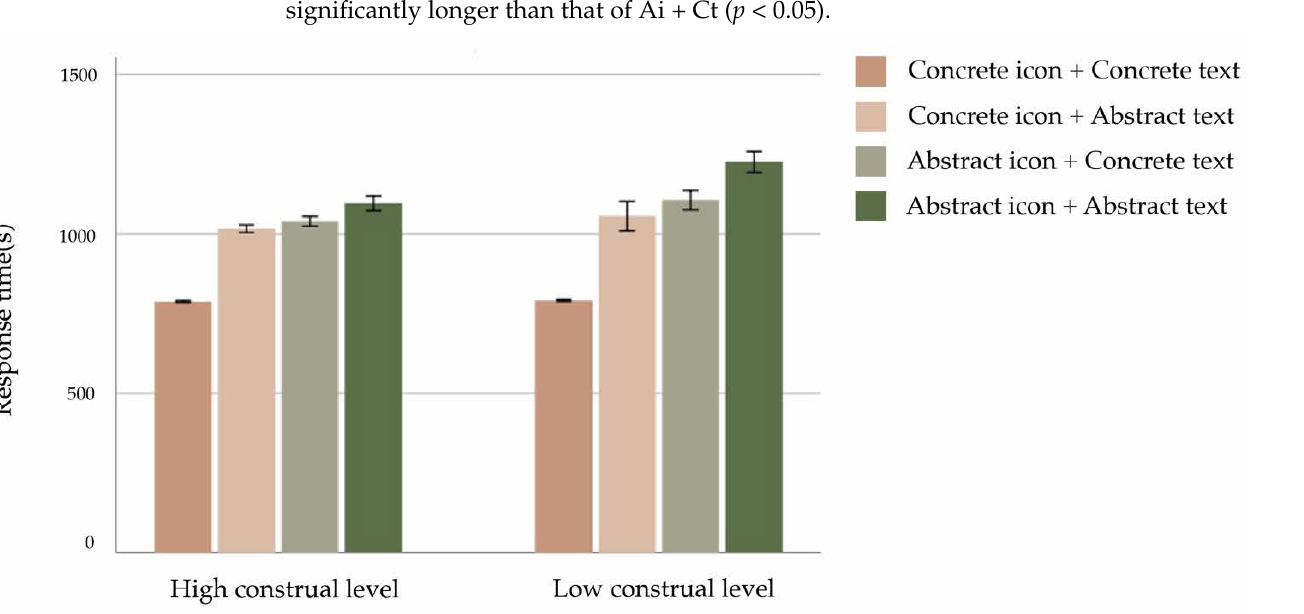
Figure 4. Response time for four types of combination design icons in users of two types of construal